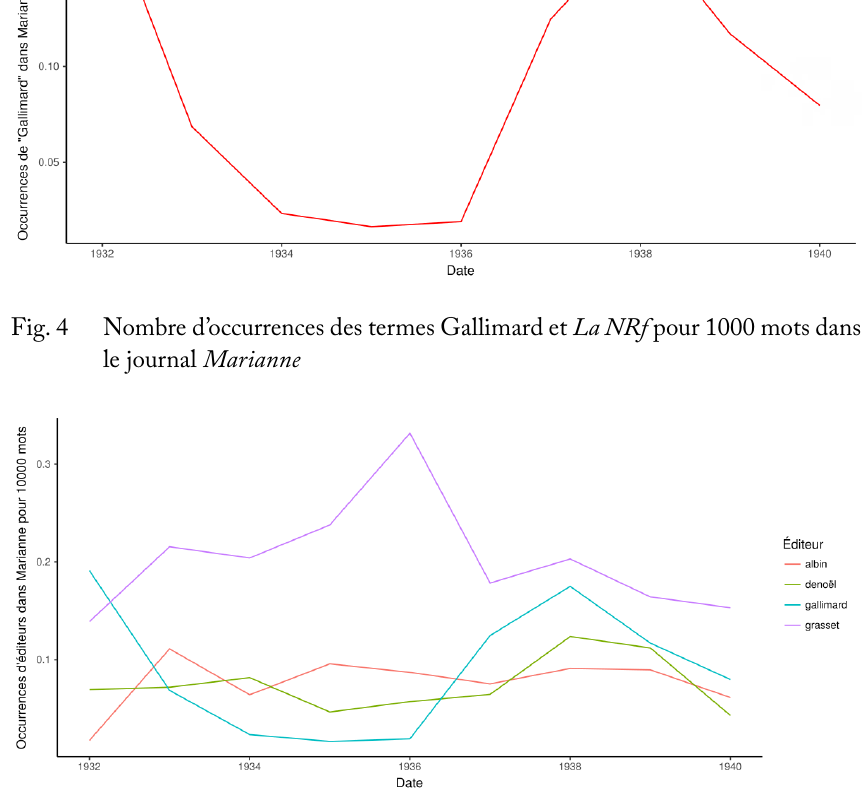
Fig. 5 Nombres d’occurrences des noms des maisons d’édition dans Marianne pour 1000